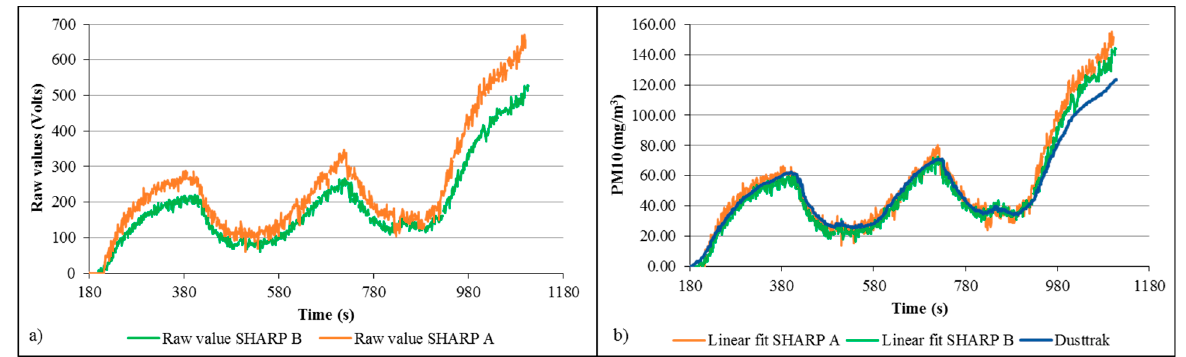
Figure 9. Dual SHARP and Dusttrak test showing ( a ) raw values data and ( b ) corrected particle measurements against Dusttrak readings.